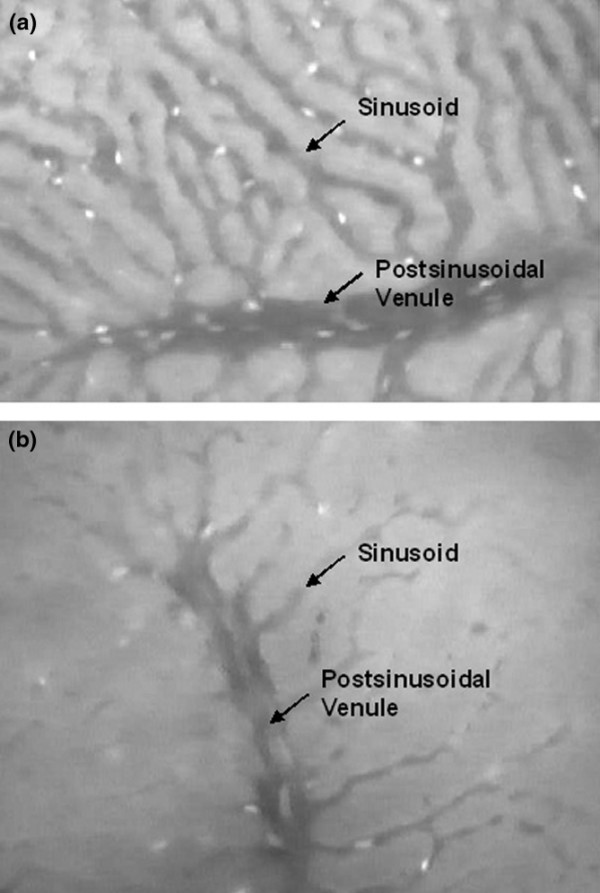
Hepatic sinusoids and postsinusoidal venules during intravital microscopy (a) 0 h and (b) 20 h after CLP demonstrate the decrease of perfused sinusoids and sinusoidal diameter during endotoxemia.